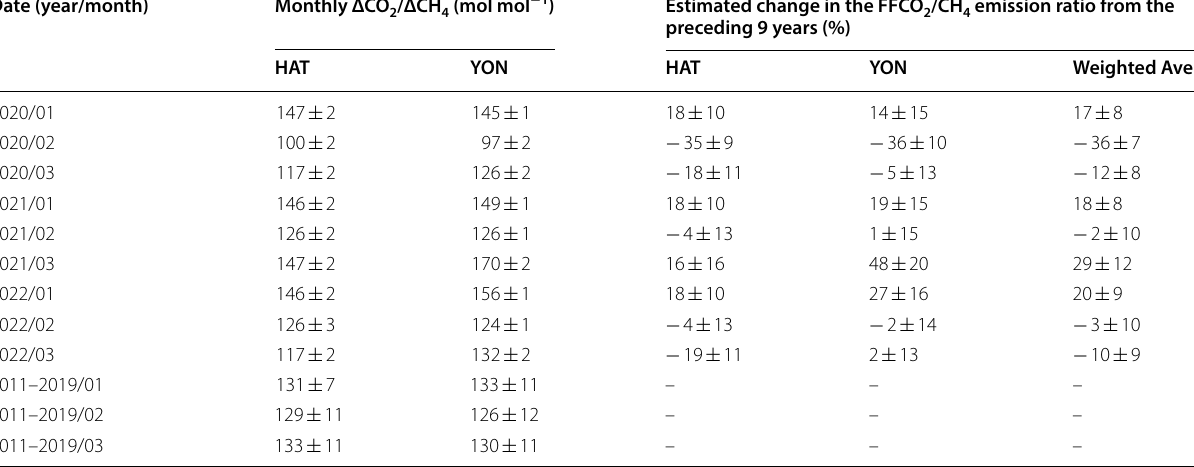
/ΔCH ratio and estimated change in the FFCO 2 4